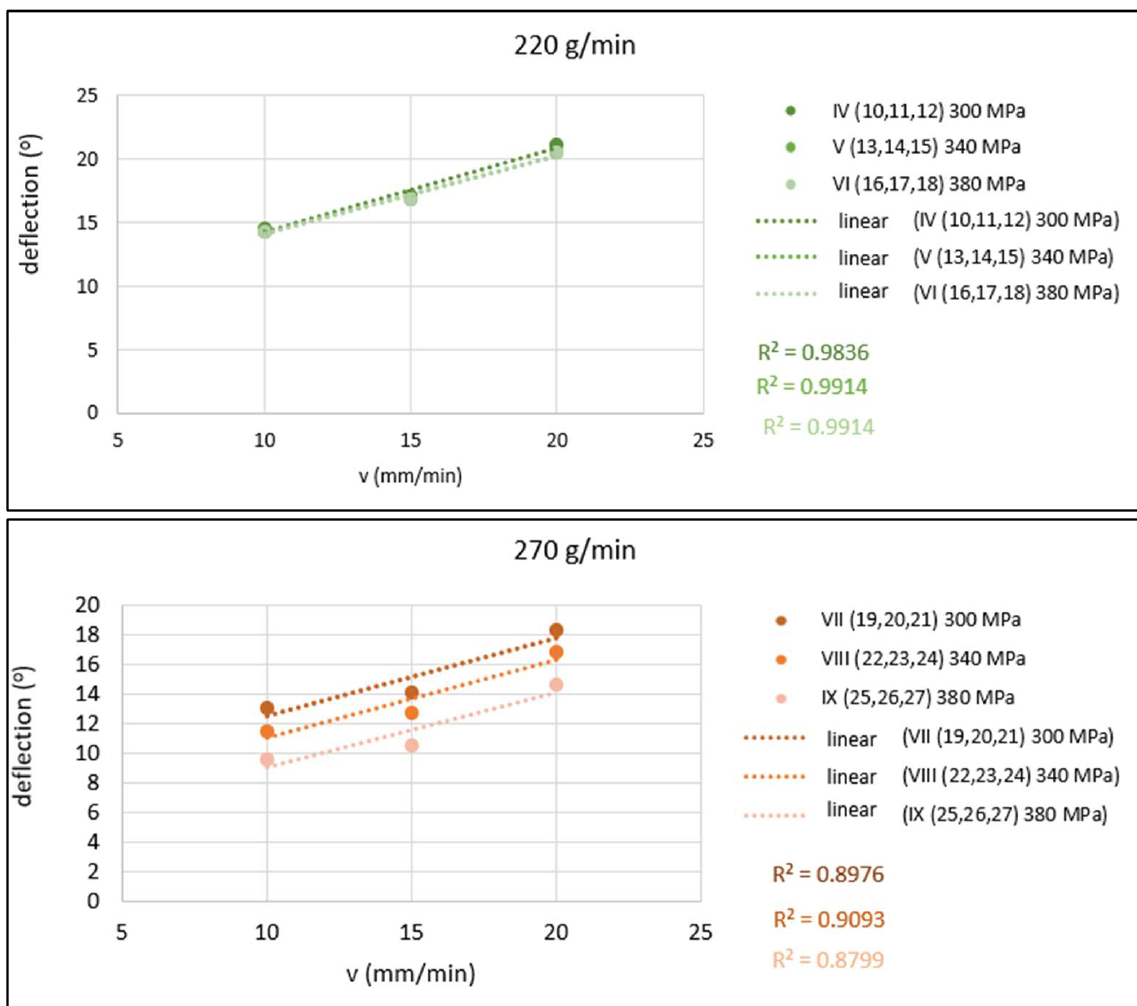
Figure 11. Graphical evaluation of 1-parametric dependencies of Ø = f( v ) for m A = 170, 220 and 270 g/min.